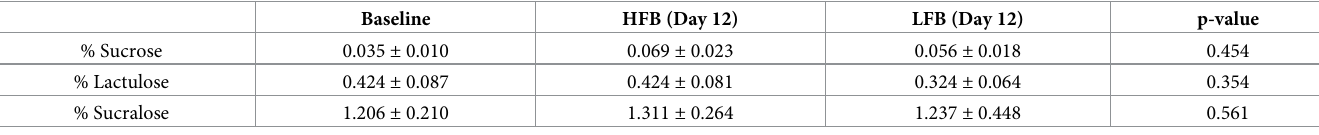
Table 3. Sugar probe excretion at